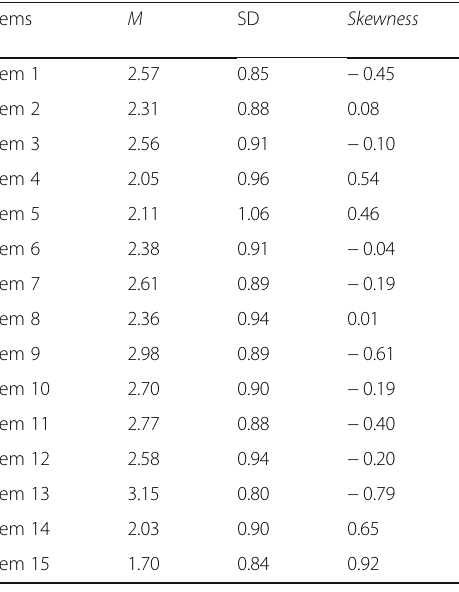
Table 2 Descriptive and metric analysis of CENVE